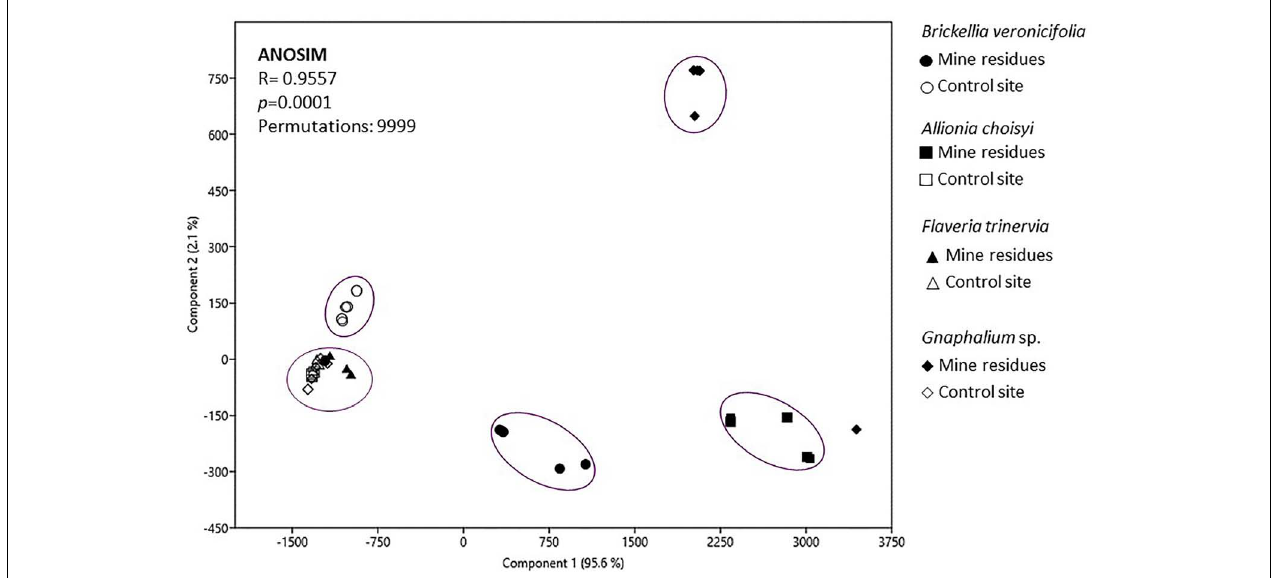
FIGURE 5 | Principal component analysis of variables characterizing leaf surfaces of four different plant species growing on mine residues (MR) or non-contaminated control site (NC). ANOSIM, analysis of